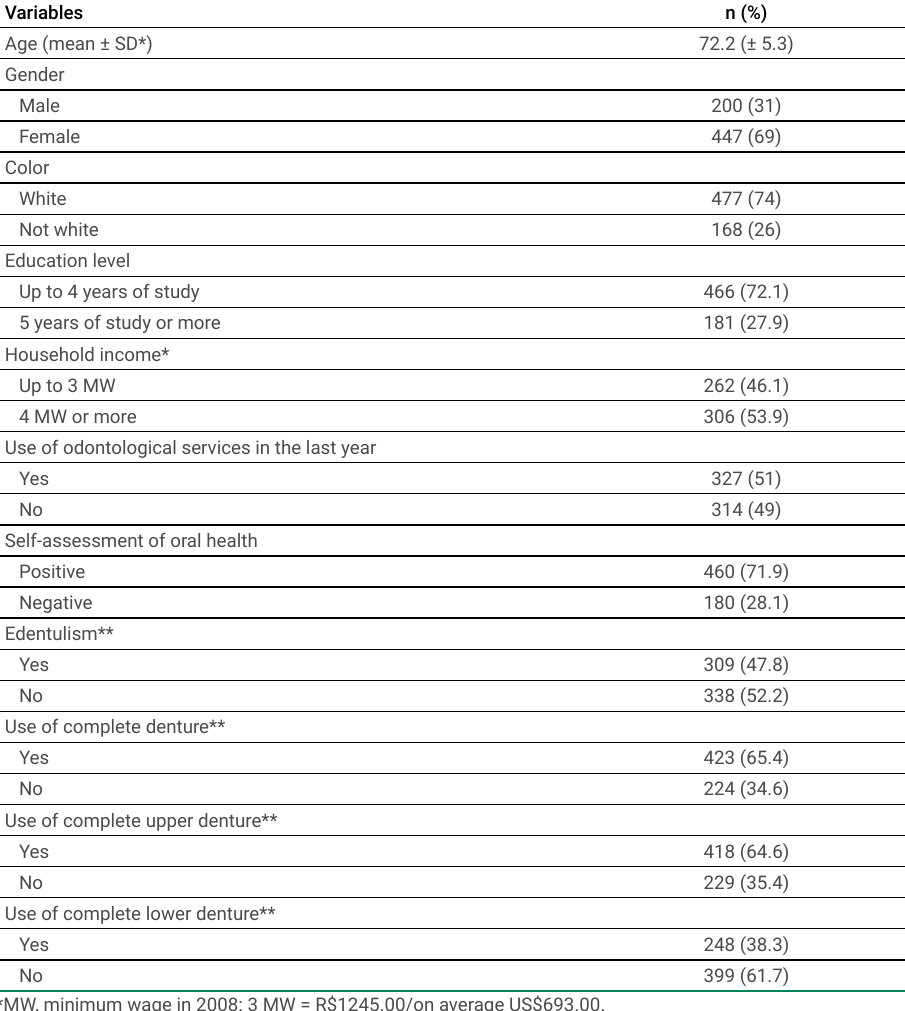
Table 2. Characteristics of participants (N =